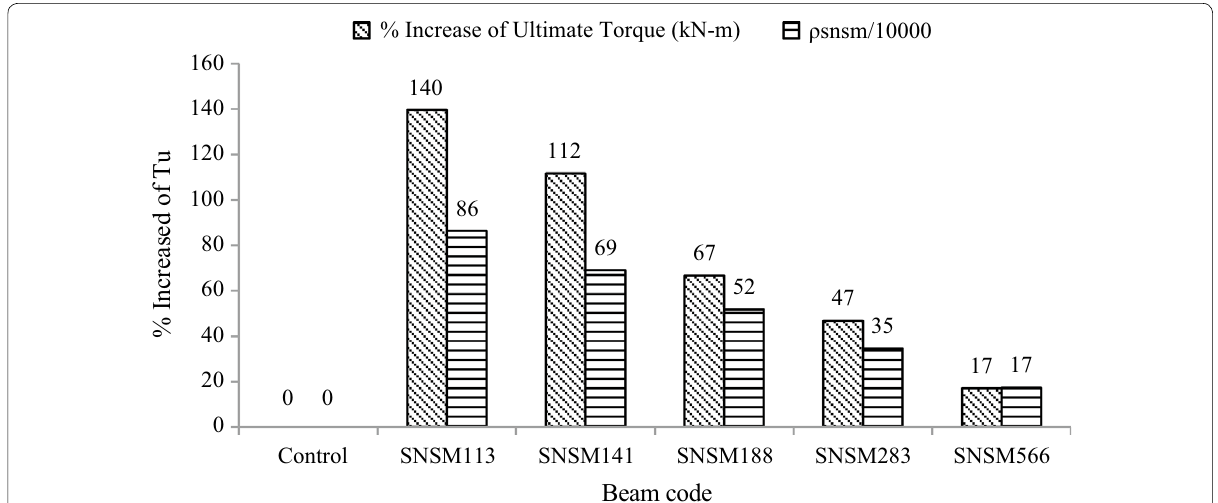
Fig. 9 Spiral NSM steel wire rope ratios and percentage improvements in the ultimate torque of the beam specimens.